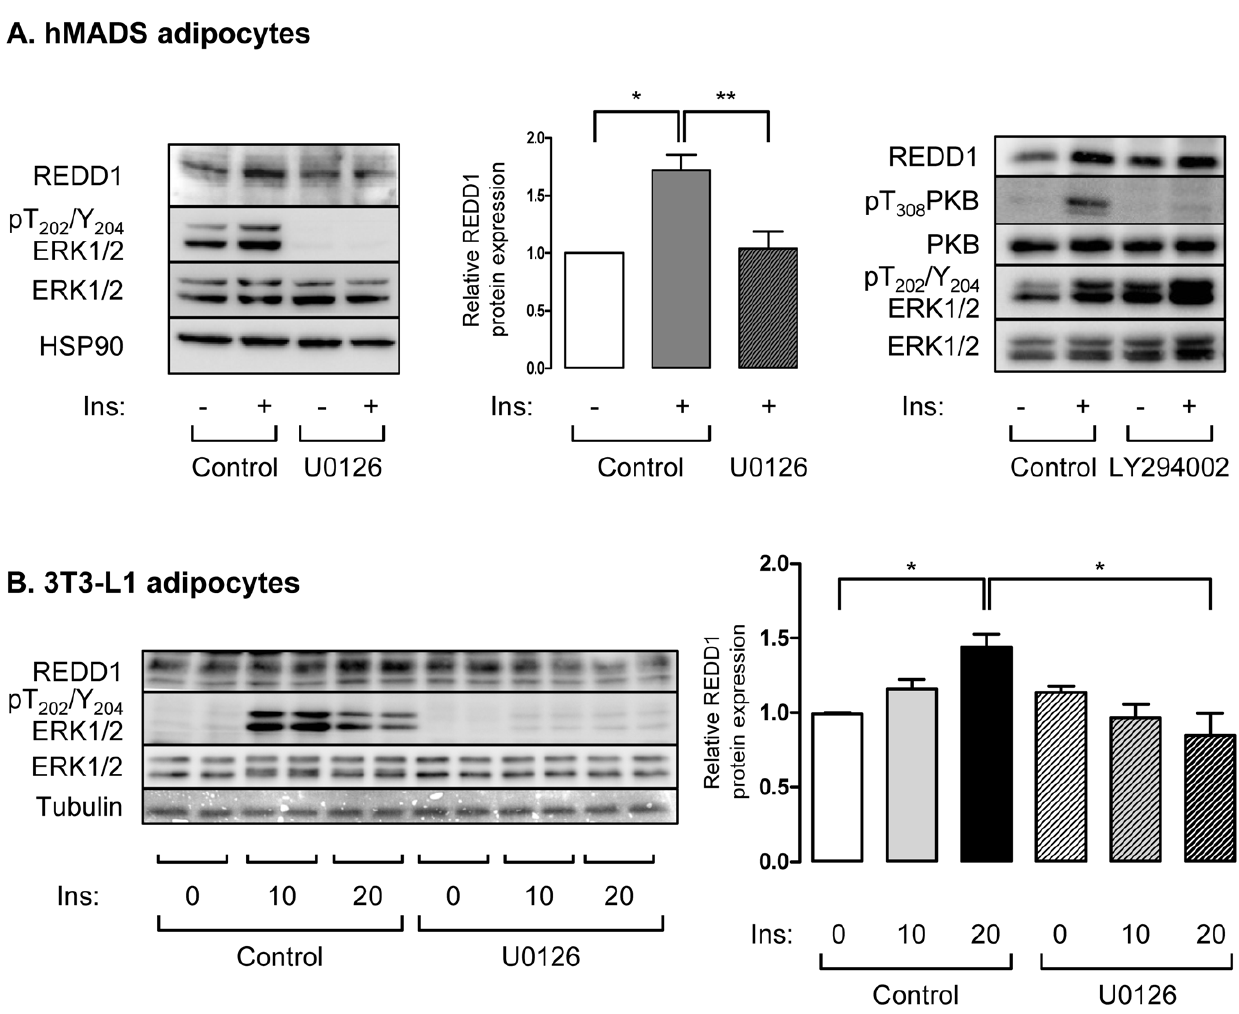
Figure 2. Insulin stimulates REDD1 expression through MEK dependent pathway in hMADS adipocytes. (A) hMADS adipocytes were stimulated with insulin (100 nM) for 20 minutes in absence or in presence of a pretreatment with U0126 (10 m M) or LY 294002 (50 m M) for 60 minutes. (B) 3T3-L1 adipocytes were stimulated with insulin (100 nM) for 10 and 20 minutes in absence or in presence of a pretreatment with U0126 (10 m M). Proteins were revealed by immunoblots using indicated antibodies. REDD1 protein level is expressed compared to HSP90 or tubulin expression and quantification of three independent experiments is shown (*p , 0.05; **p , 0.01).